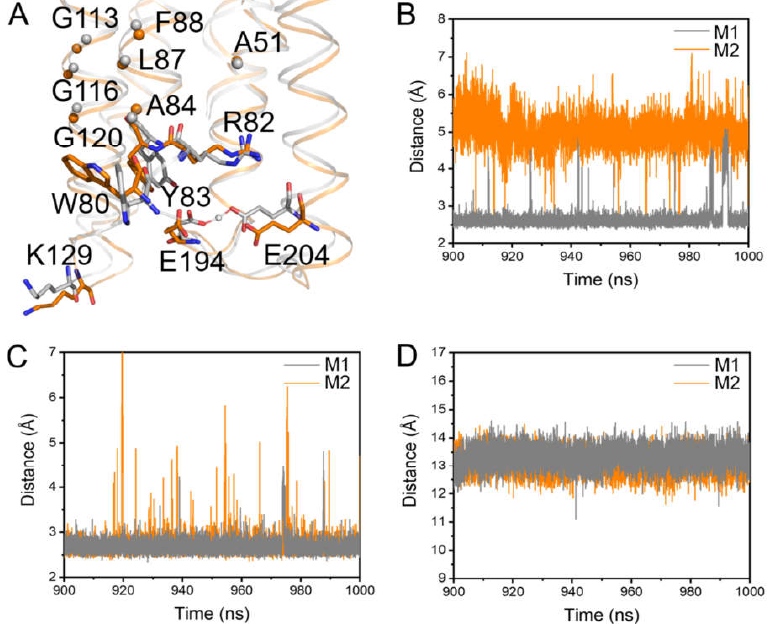
Figure 5. Conformation changes on the extracellular side induced by S-TGA-1. ( A ) Detailed changes in the key residues in the extracellular side in M1 (grey cartoon, sticks, and spheres) relative to M2 (orange cartoon, sticks, and spheres); ( B – D ) the evolution of the distance between the key residues from the last 100 ns simulations of M1 (grey line) and M2 (orange line): ( B ) E194-E204; ( C ) Y83-E194; ( D ) R82-A51. Repeated simulations could reproduce these behaviors (Figure S5 and Table S3). Int. J. Mol. Sci. 2022 , 22 , x FOR PEER REVIEW 10 of 23 The RMSDs of M5 and M6 over the total simulation were more significant than that of M1, and the same for RMSFs of the C-D loop, helices F and G, with the difference caused by W80A more prominent (Figure 6A–D). These results indicate that W80 and K129 could mediate the connection between the adjacent monomeric helices by binding with S-TGA- 1 to maintain appropriate dynamics for the bR trimer. DCCM and DCCN analyses showed that the change in inter-residue interactions caused the negative correlations to increase significantly, especially on the extracellular surface (Figure 6E–H), resulting in reduced stability for the bR trimer.